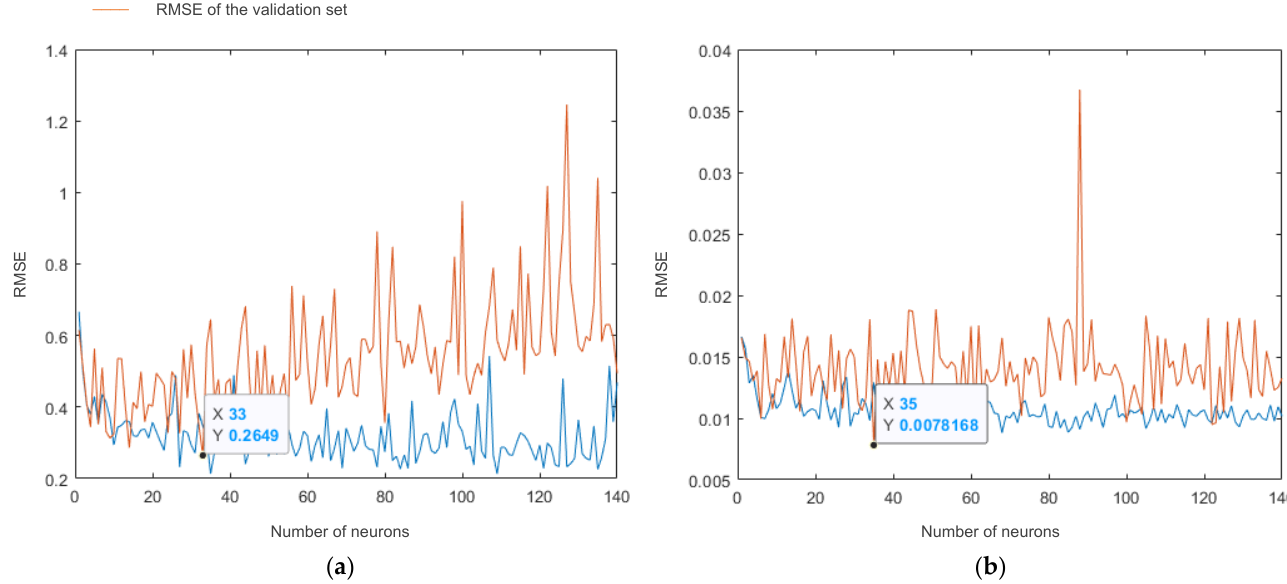
Figure 9. Individuation of the optimal number of neurons in the hidden layer corresponding to the minimum RMSE for ( a ) ANN1 and ( b ) ANN2.